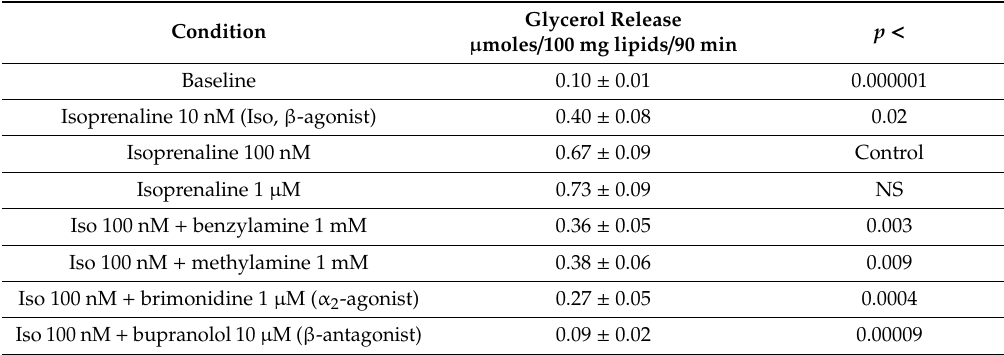
Table 2. Inhibitory e ff ect of methylamine on isoprenaline-stimulated lipolysis in human adipocytes.